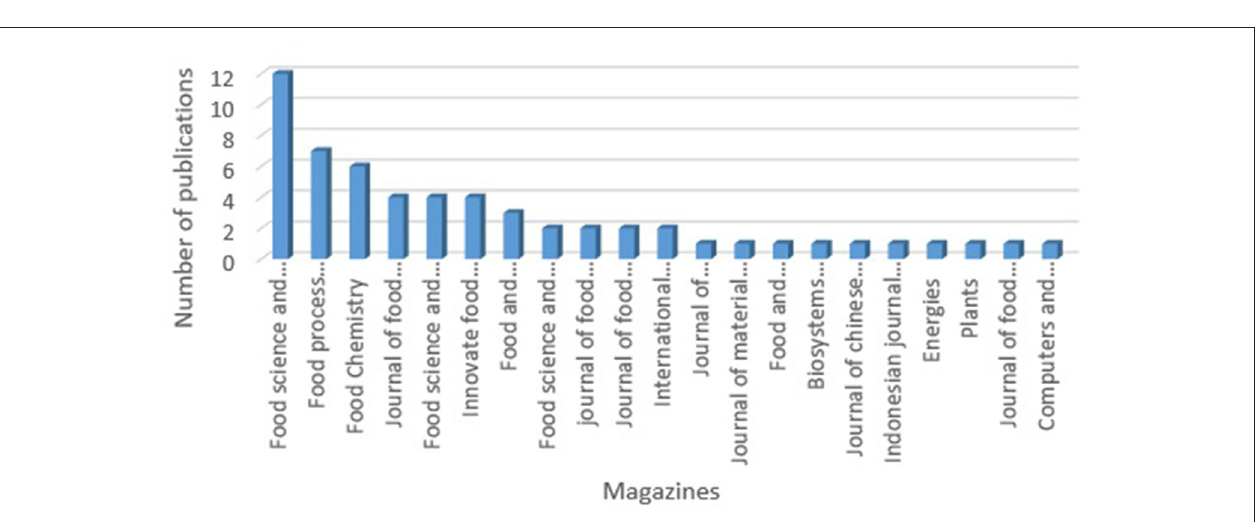
FIGURE 3 | Countries that produced publications. Source: the authors.